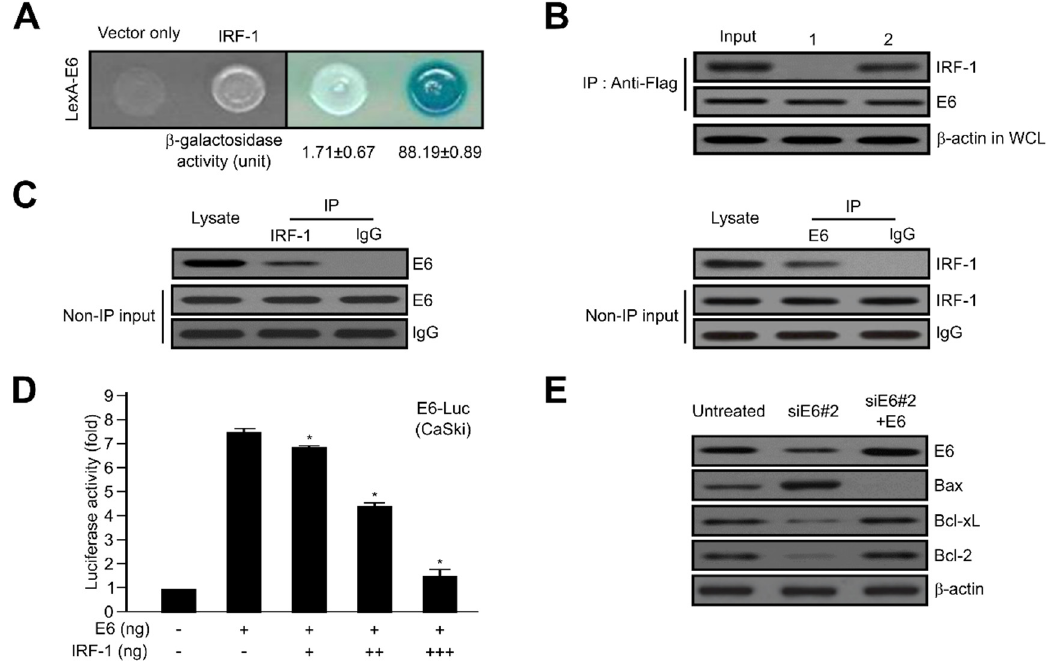
Figure 4. Direct interaction between HPV16 E6 and interferon regulatory factor-1 (IRF-1) tumour suppressor proteins. ( A ) Positive interactions were monitored to determine the cell growth in the medium lacking leucine and β -galactosidase activity (unit) using o -nitrophenyl β -D-galactopyranoside (ONPG). ( B ) Co-immunoprecipitation of HPV16 E6 with IRF-1. Immunoprecipitation was conducted using an anti-Flag antibody and whole cell lysates from transfected cervical cancer cells. After immunoprecipitation, the precipitated proteins were detected using anti-HPV16 E6 and anti-IRF-1 antibodies. Lane 1, pcDNA3.1 (vector only) and pcDNA3.1 / Flag-HPV16 E6 transfectants; lane 2, pcDNA3.1-IRF-1 and pcDNA3.1 / Flag-HPV16 E6 transfectants. β -actin served as a loading control. ( C ) Co-immunoprecipitation of endogenous HPV16 E6 and IRF-1 indicated an interaction between HEK293T cells. Rabbit immunoglobulin G (IgG) served as an IP-negative control. ( D ) Activity of HPV16 E6-dependent transcription by IRF-1 tumour suppressor. CaSki cervical tumour cells were co-transfected with 500 ng of HPV16 E6-Luc, 500 ng of a HPV16 E6